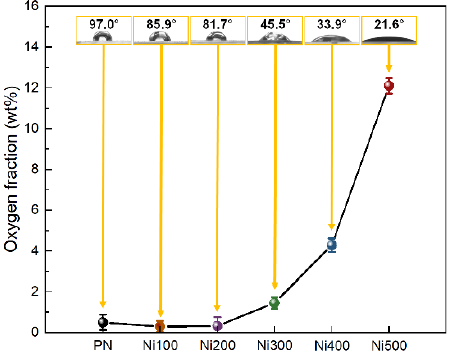
Figure 3. Oxygen weight fraction plots of PN, Ni100, Ni200, Ni300, Ni400, and Ni500 measured using EDS mapping analysis. The yellow boxed insets at each point in the images illustrate the water contact angle and real images of droplets on the surface for each sample.